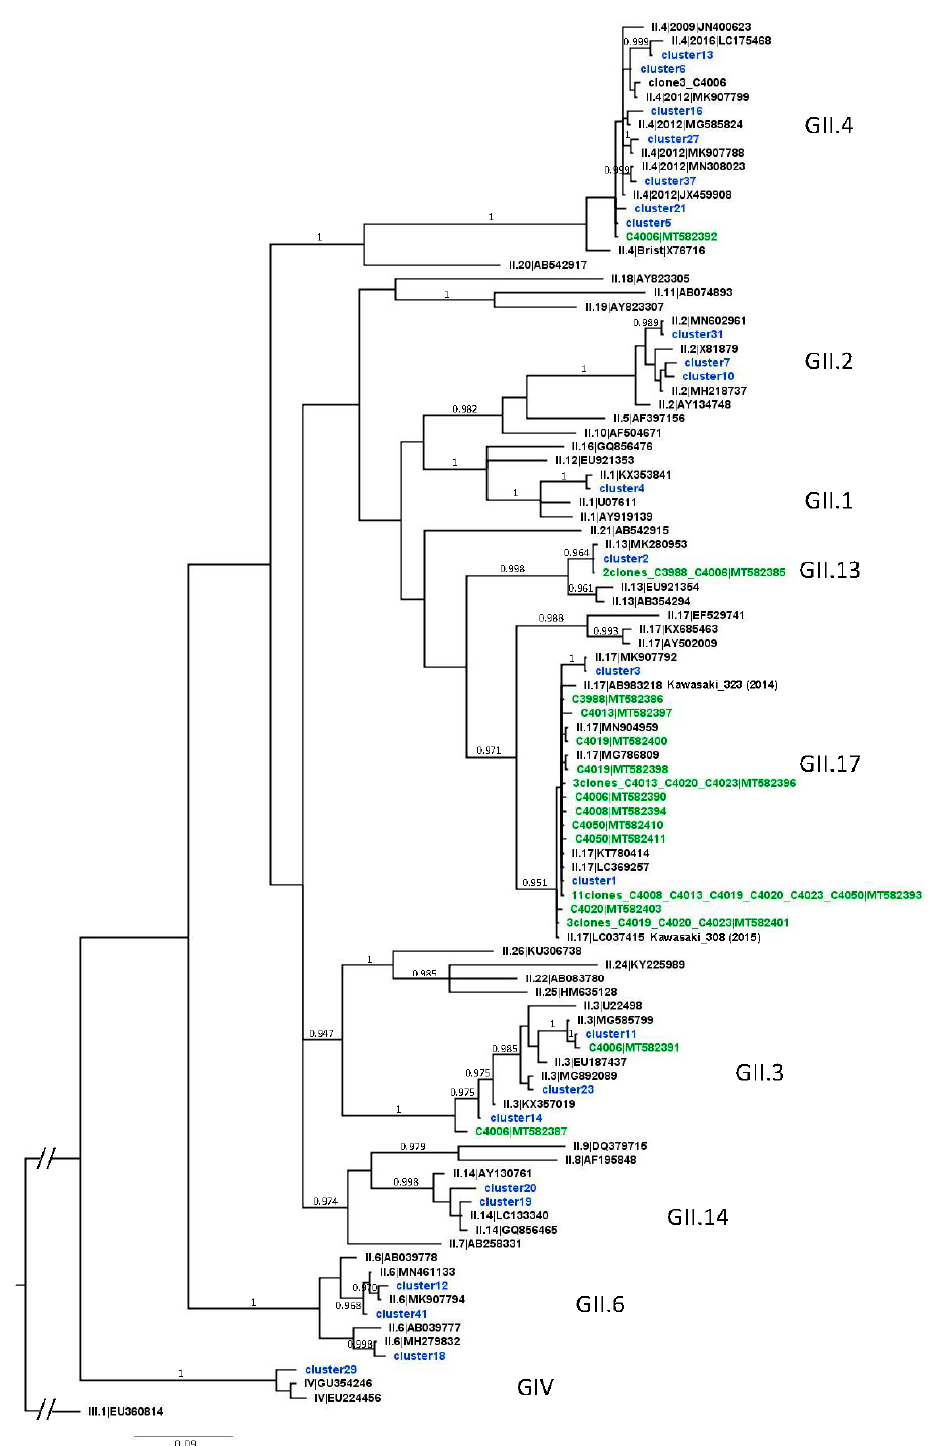
Figure 3. Phylogenetic tree of VP1 clones and clusters from shellfish samples. Bayesian phylogenetic analysis was used to generate this tree with NoV GII, GIII, and GIV sequences retrieved from GenBank (black, with genotype | accession number), sequences of clones (green, with sample name | accession number), and of clusters (blue) obtained from the shellfish samples. Posterior probabilities above 0.95 are indicated just above or below the supported branch. The GIII.1 sequence was used as outgroup to root the